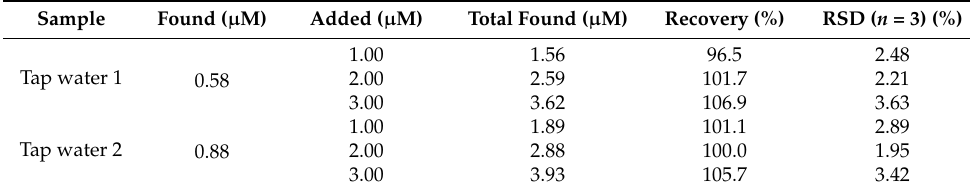
Table 1. Determination of ClO − in tap water samples ( n = 3).